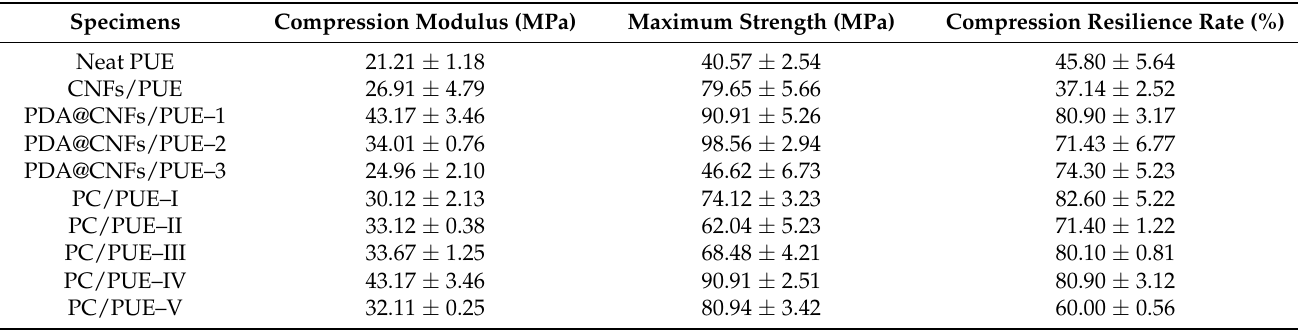
Table 3. Data summary of PUE composites under static compression